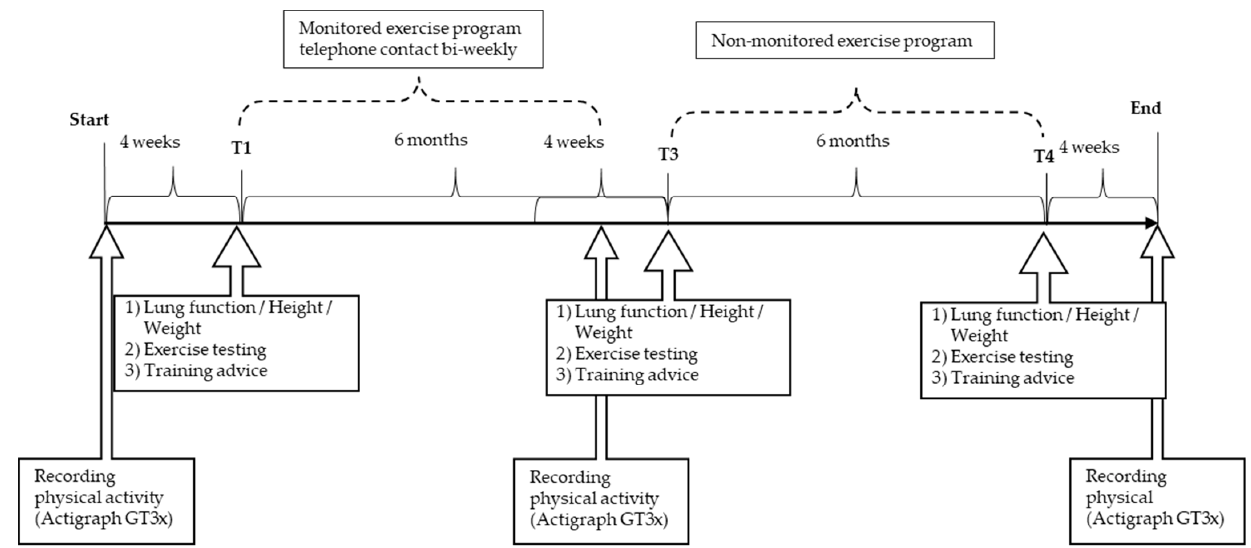
Figure 2. Timeline of CFmobil exercise program.